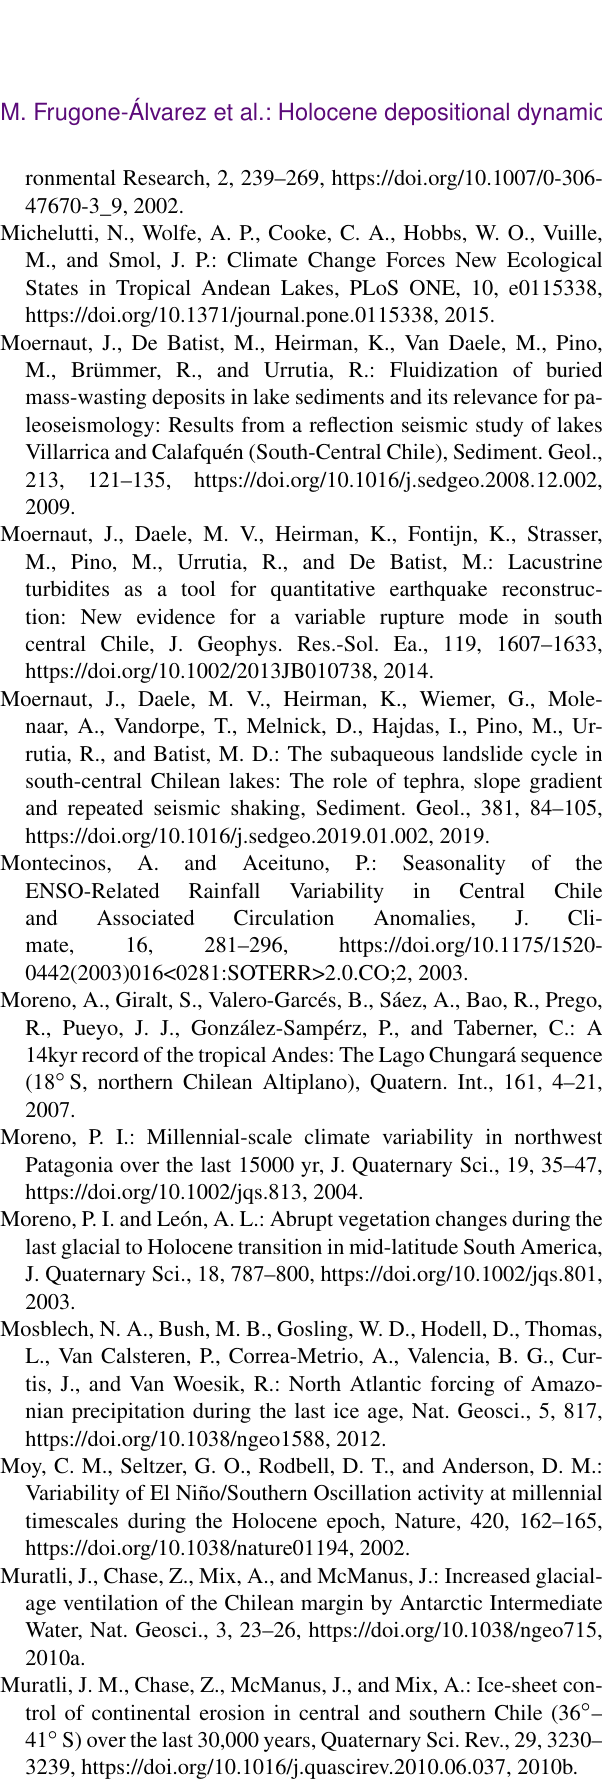
Taberner, C.: Carbonate and organic matter sedimentation and isotopic signatures in Lake Chungará, Chilean Altiplano, dur- ing the last 12.3kyr, Palaeogeogr. Palaeocl., 307, 339–355, https://doi.org/10.1016/j.palaeo.2011.05.036, 2011. QGIS Development Team: QGIS Geographic Information